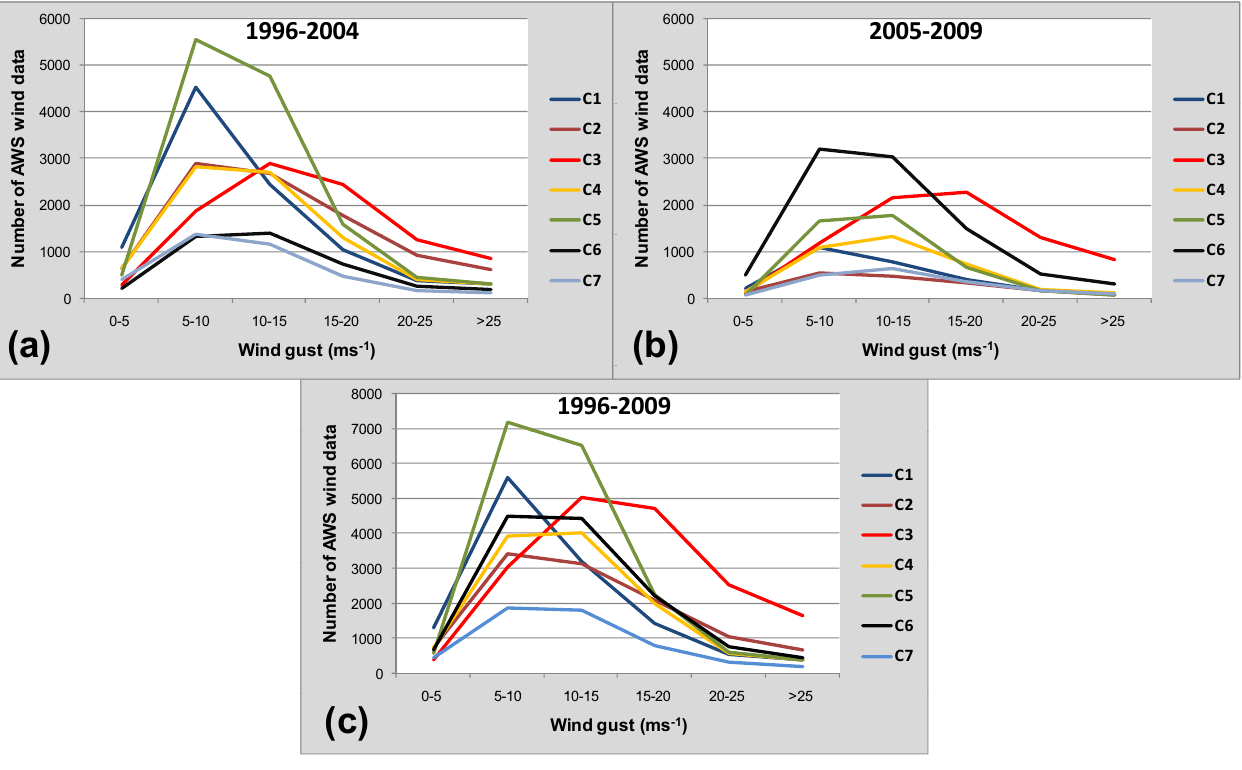
Fig. 7. Total number of AWS for all the events included in each cluster and gust intensity threshold (in ms − 1 ): (a) MEDEX period, (b) validation period, (c) the whole period of the